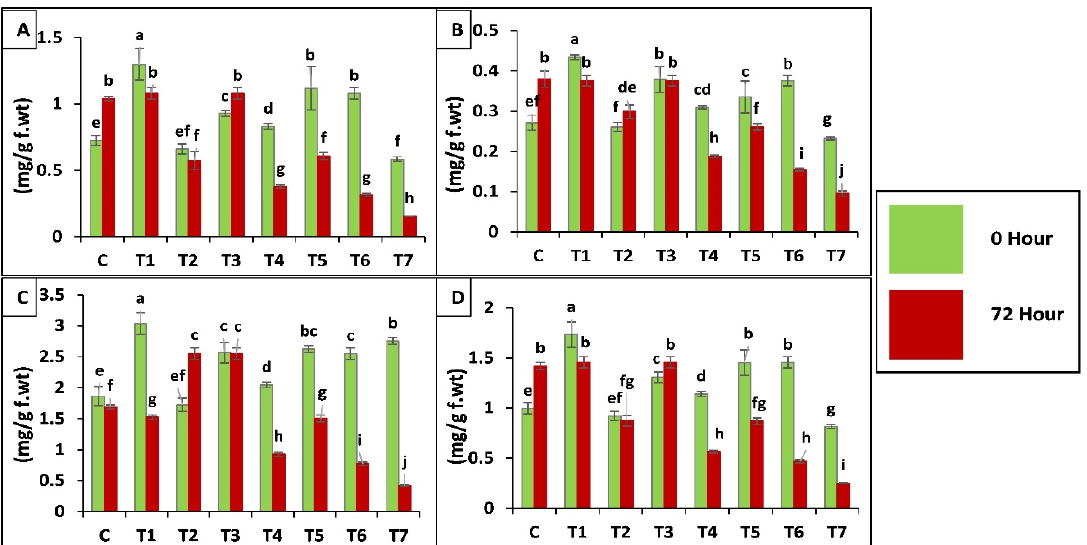
Figure 7. Effect of entomopathogenic fungi on chlorophyll a ( A ); chlorophyll b ( B ); carotenoids ( C ) and total chlorophyll content ( D ) of plants, at 0 h and 72 h of insect attack . Treatment detail: uninoculated and uninfested control (C); seed coating with B. bassiana OFDH1-5 (T1); soil drenching with B. bassiana OFDH1-5 (T2); seed coating with T. asperellum GDFS1009 (T3); soil drenching with T. asperellum GDFS1009 (T4); seed treatment with binary combination of B. bassiana OFDH1-5 + T. asperellum GDFS1009 (T5); soil drenching with binary combination of B. bassiana OFDH1-5 + T. asperellum GDFS1009 (T6); infested control (insect control) (T7). 2.4. Transcriptome analysis and identification of differentially expressed genes (DEGs) in ACB. Means followed by different lowercase letters above each bar indicates significant differences among the treatments (p < 0.05).